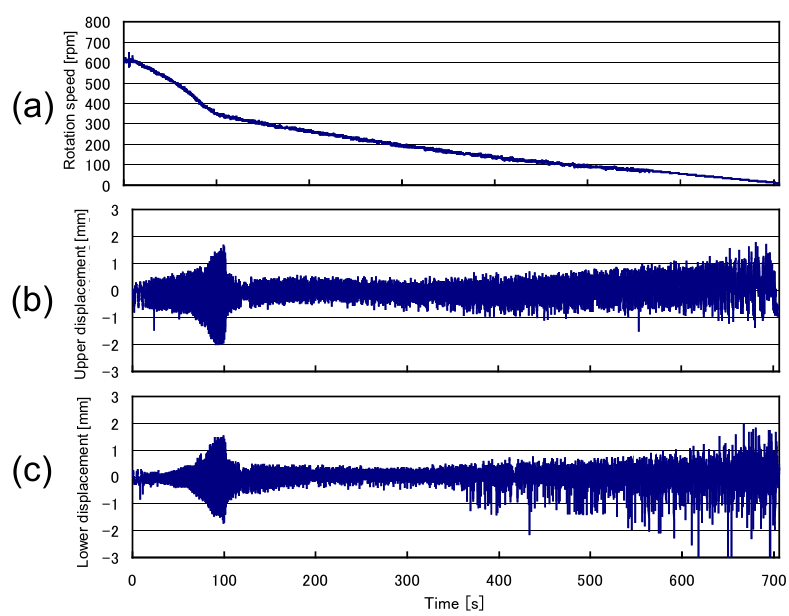
Figure 16. Free-run experimental results using the flywheel rotor with 100 g in the case of the fixed stator, representing ( a ) a natural rotation decay curve, ( b ) displacements at the center position of the rotor and ( c ) displacements of the stator at just the upper position of the rotor.